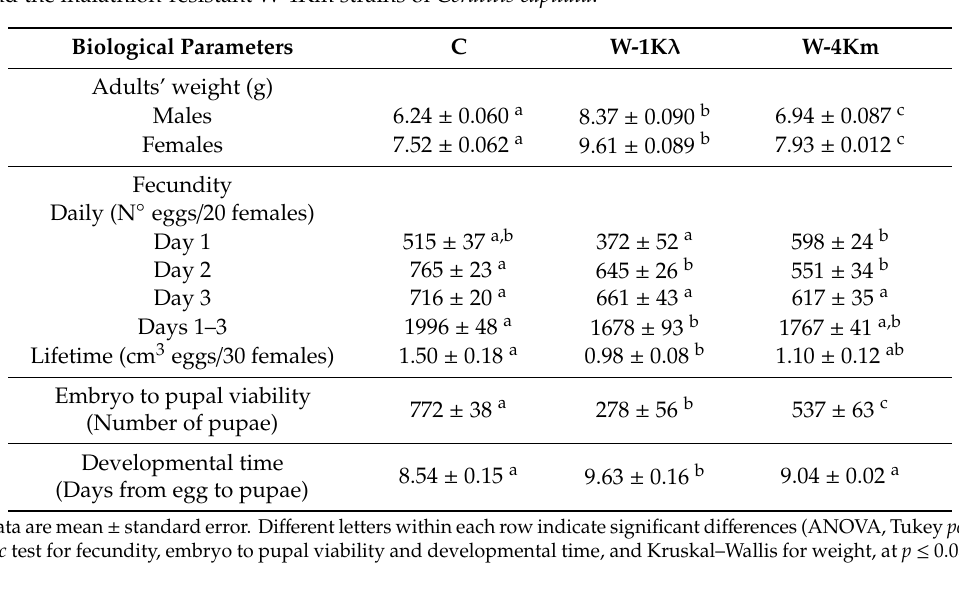
Table 2. Biological parameters of flies from lambda-cyhalothrin-resistant W-1K λ , the susceptible C, and the malathion-resistant W-4Km strains of Ceratitis capitata .